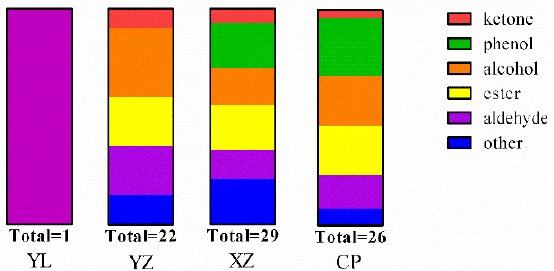
Figure 4. Change of VOCs species of Zhenba bacon with different stages using GC-MS. Fresh: raw sample; YZ: cured sample; XZ: smoking sample; CP: finished sample; VOCs: volatile organic com- pounds. Table 2. Volatile compounds in four stages of Zhenba bacon by GC–MS.